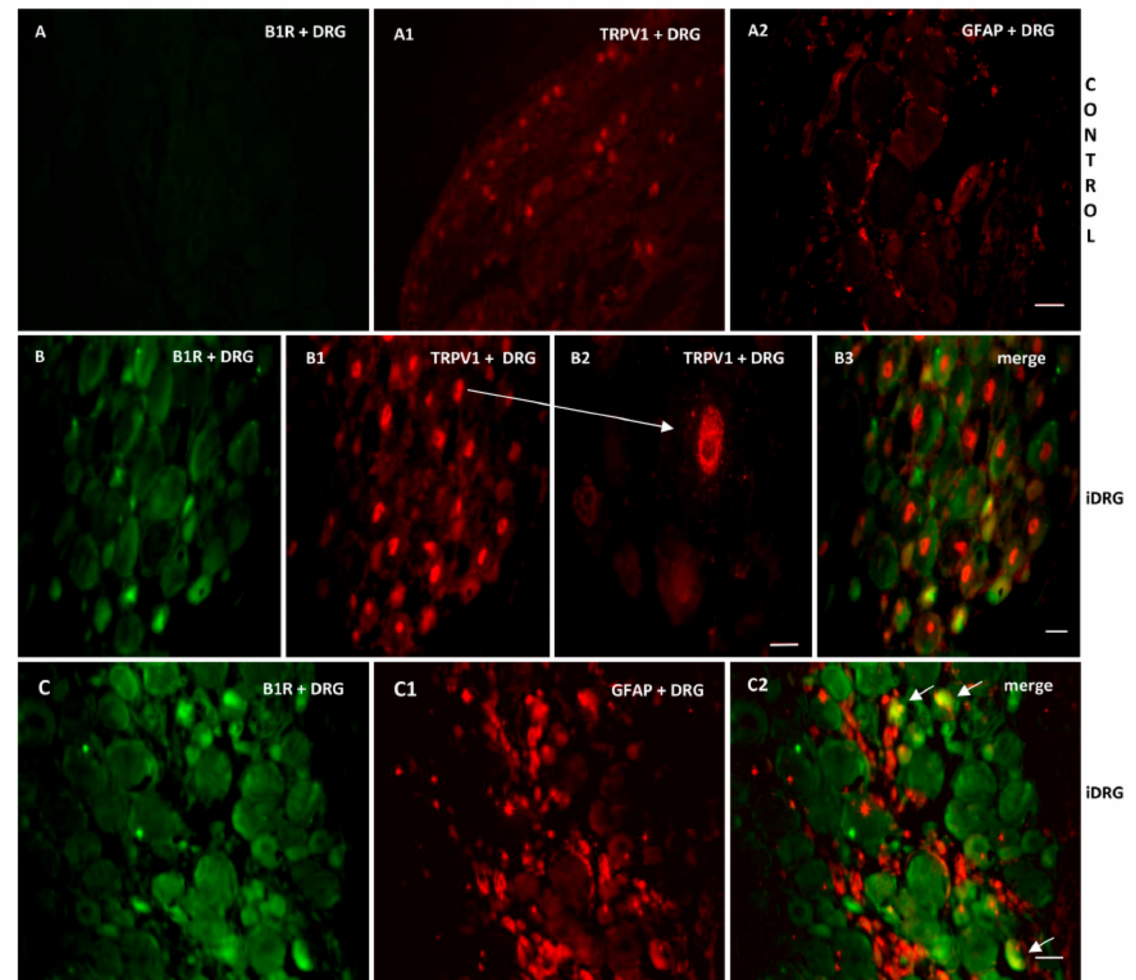
Figure 8. Co-expression of B1R with TRPV1 or GFAP in the ipsilateral lumbar DRG (iDRG). Representative microphotographs by immunofluorescence of B1R (green, B , C ) and TRPV1 (red, B1 , B2 ) and GFAP (red, C1 ) in the iDRG of PSNL rats. Control iDRG ( A , A1 , A2 ) exhibit no staining for B1R ( A ) and a moderate staining for both TRPV1 ( A1 ) and GFAP ( A2 ). B1R and TRPV1 are co-expressed in the DRG ( B3 ). Enlarged DRG showing TRPV1 staining around the nucleus (arrow, B2). A punctual co-localization of B1R with GFAP (arrow, possibly issued from satellite cells) was found in the lumbar DRG ( C2 ). Scale bar = 120 µ m ( A – A2 , 10 × ), 60 µ m (other panels, 20 × ), 75 µ m ( B2 , 60 ×